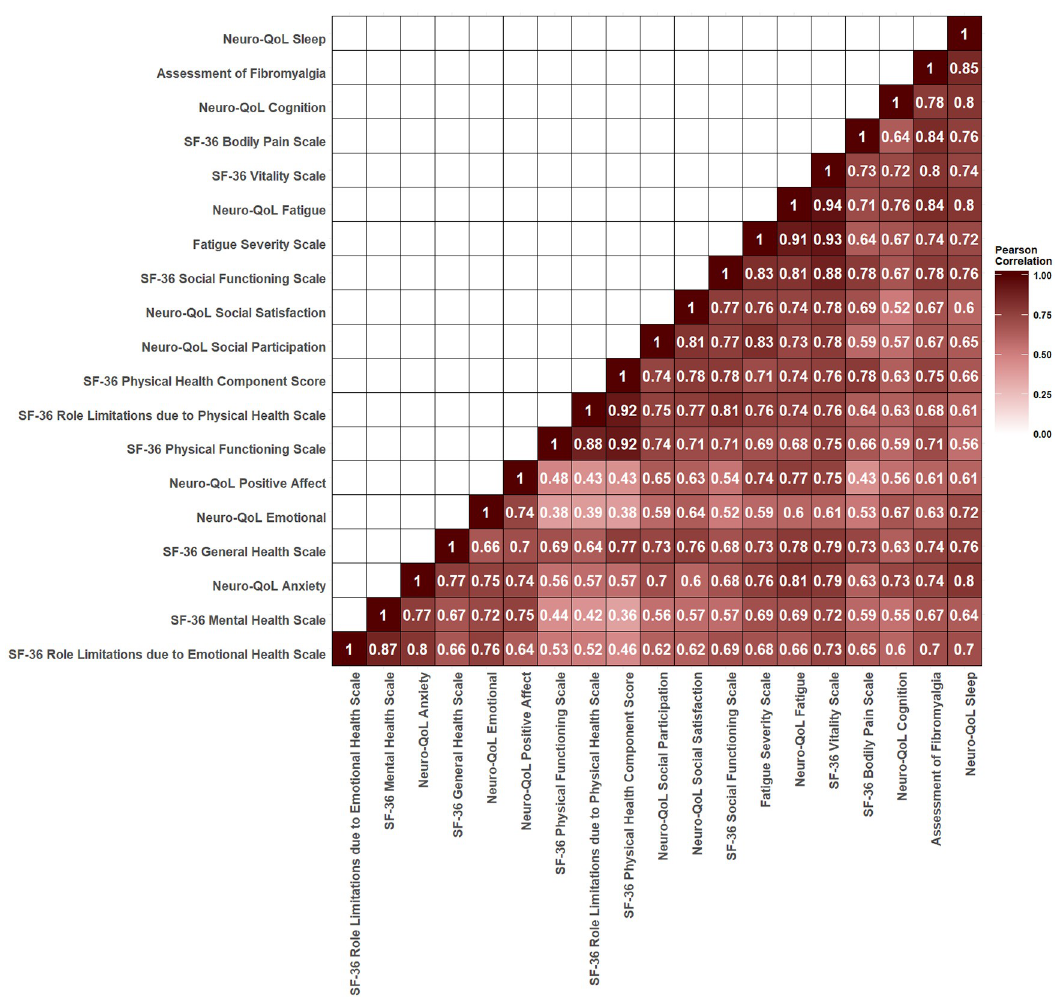
Fig 2. Correlation Analysis Between Symptom Scales. Scores were analyzed for pairwise covariation by the Pearson correlation analysis. All correlation coefficients with P < 0.05 except for the correlation between the Short Form-36 version 2 (SF-36) Physical Health Component score and the SF-36 Mental Health subscale, which had a P =